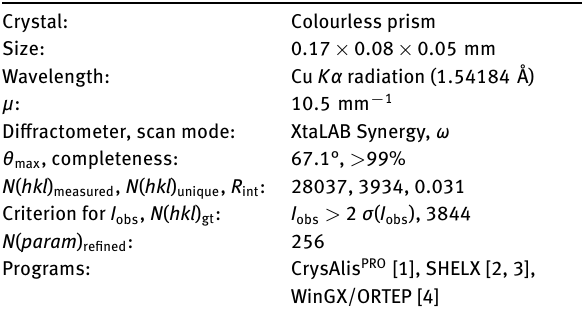
Table 1: Data collection and handling.